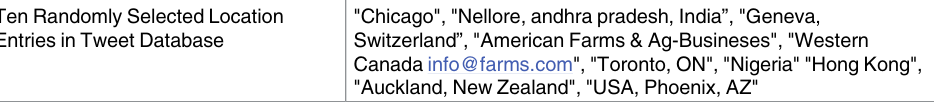
Table 3. Sample of location information available from profile information for AI-related Twitter messages Ten Randomly Selected Location Entries in Tweet